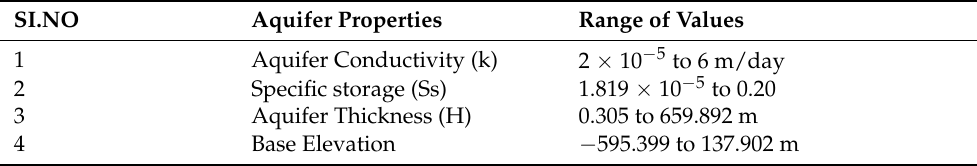
Table 1. Range of Values used for Aquifer Properties from